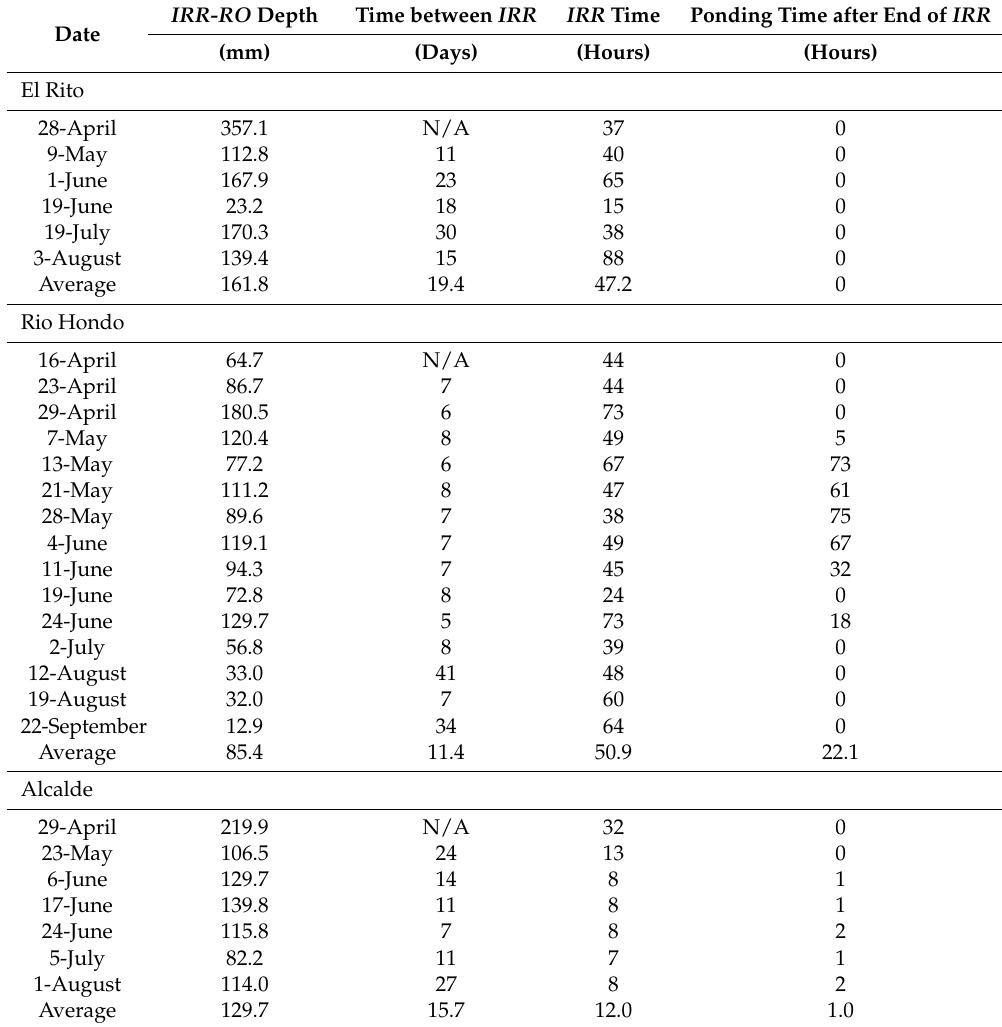
Table 2. Irrigation ( IRR ) summary for the 2013 irrigation season at the three study sites, El Rito, Rio Hondo, and Alcalde. N/A = Data Not